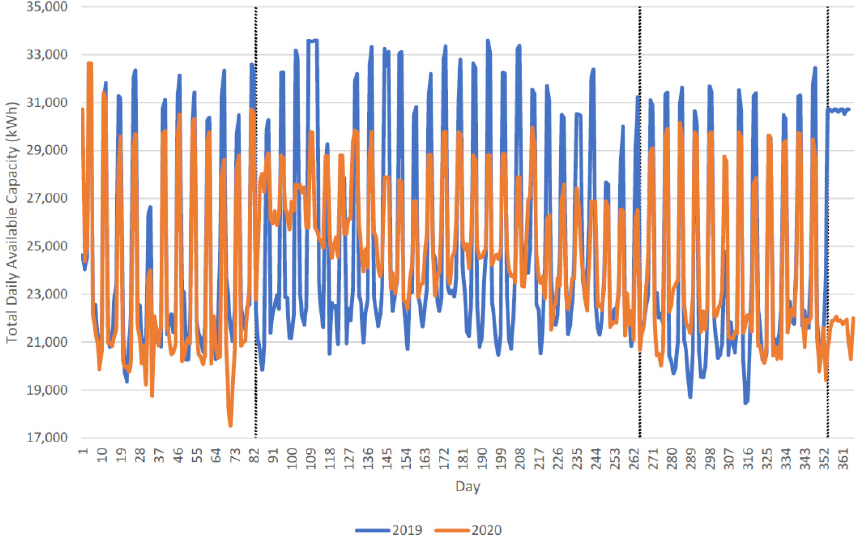
Figure 5. Total available capacity from the fleet for each day during 2019 and 2020. Pre-lockdown, post-lockdown and new academic term periods are identified as for Figure 3.